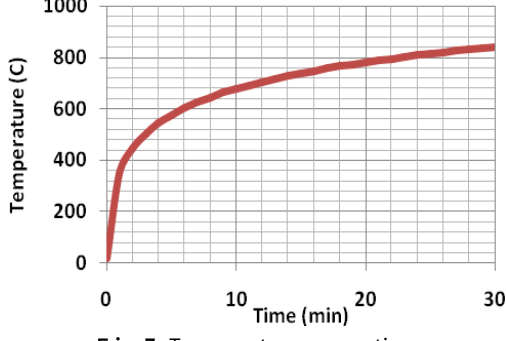
Fig. 7. Temperature versus